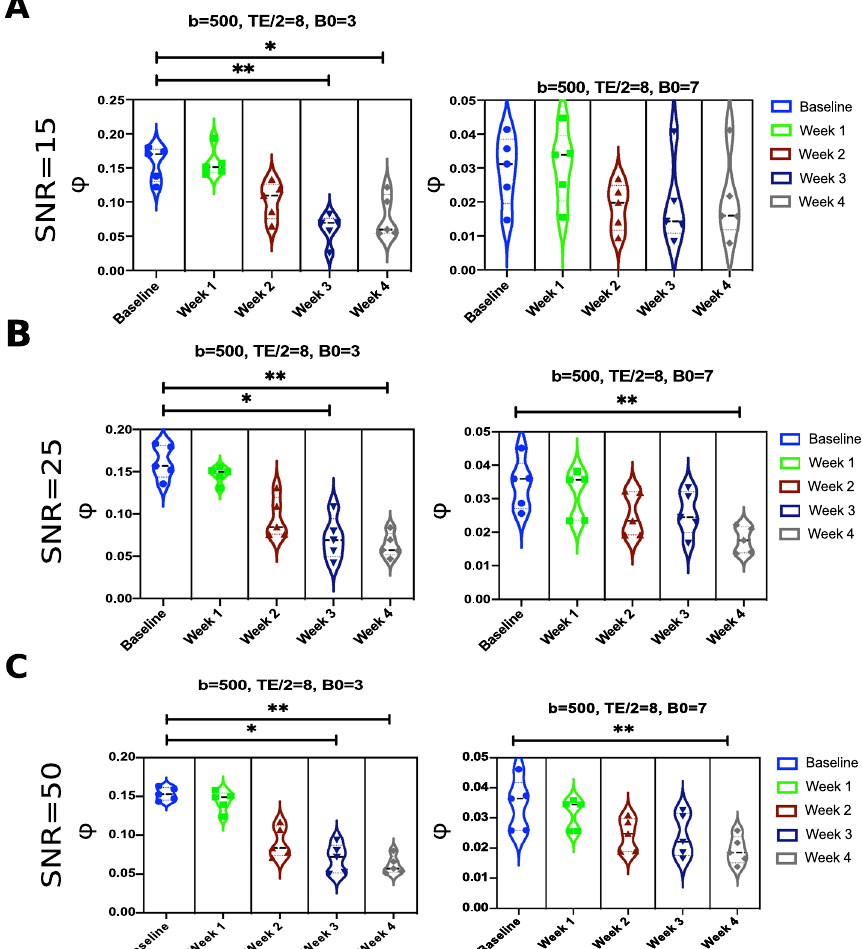
Figure 7. The effect of different SNR, namely, ( A ) SNR = 15, ( B ) SNR = 25, and ( C ) SNR = 50, on the statistical significance in terms of the ratio of minimal signal loss φ . The simulations are carried out on our realistic (OCT) angiograms before and after occlusion using ASL